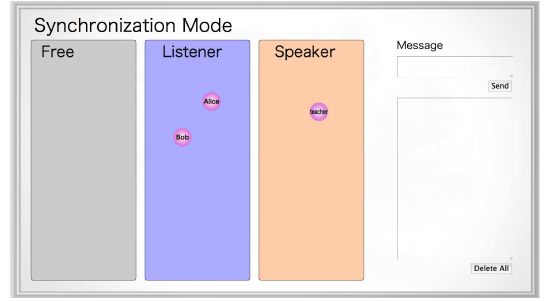
Fig. 6. Synchronization mode